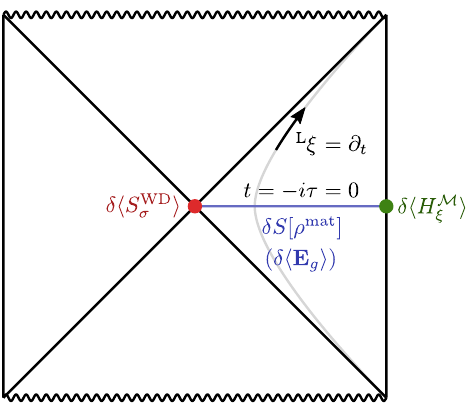
Figure 1. Euclidean preparation (a) and Lorentzian evolution (b) of a thermal setup. The Eu- clidean background in panel a is symmetric with respect to the flow ξ E of thermal time τ . The state is prepared on the surface Σ , bounded in the bulk by the entangling surface σ , around which ξ E gen- erates rotations, and on the spacetime boundary by R . In panel b, the Lorentzian time t = − iτ evo- lution corresponds to a boost ξ L that generates horizons. The Σ , σ , and R surfaces are embedded as shown (in the same colours as in panel a) in this Lorentzian geometry, with σ giving the bifurcation surface of the horizons. Elements of the first law of generalized entropy are written in the colours of the surfaces on which they respectively reside: the variations of the Dong entropy h S WD